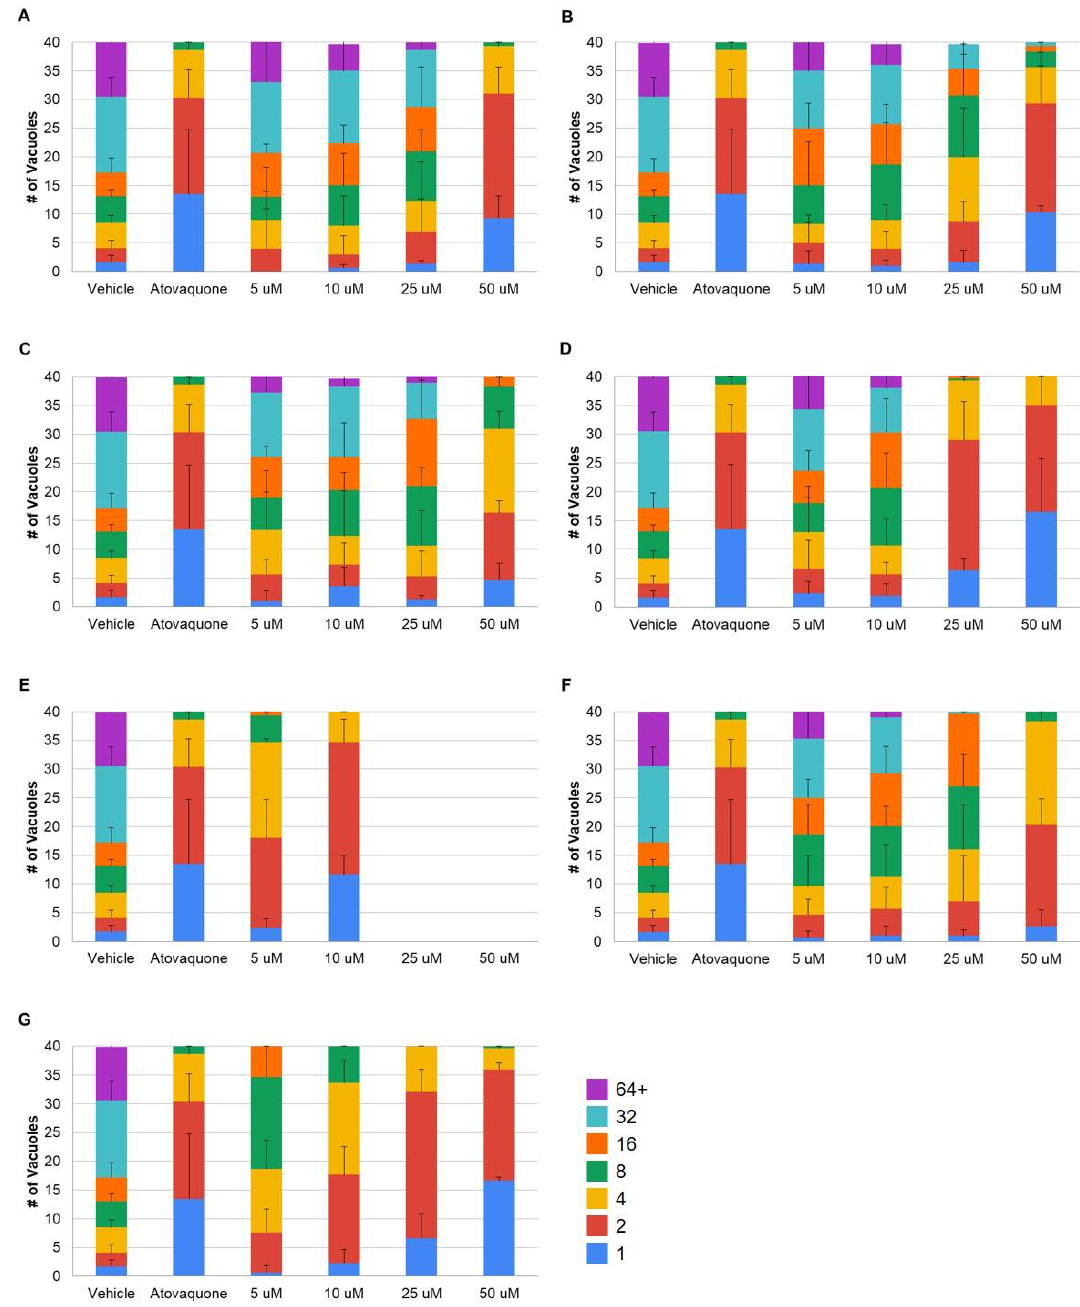
Figure 1. Bisphenol Z derivatives possess the capacity to inhibit the intracellular growth of Toxoplasma gondii , as revealed by doubling assays. Intracellular parasites were grown in the presence of increasing concentrations of the BPZ compounds for 30 h prior to fixation, staining, and enumeration of the number of parasites in each of the 40 parasitophorous vacuoles. The antiparasitic drug atovaquone (2.5 µM) was included to compare the efficacy of the ( A ) parent BPZ, ( B ) methyl-BPZ, ( C ) palmitoyl-BPZ, ( D ) ethyl-BPZ, ( E ) isopropyl-BPZ, ( F ) hexanoyl-BPZ, and ( G ) dansyl-BPZ compounds. The data presented are the averages of three independent experiments, and error bars represent standard deviation.